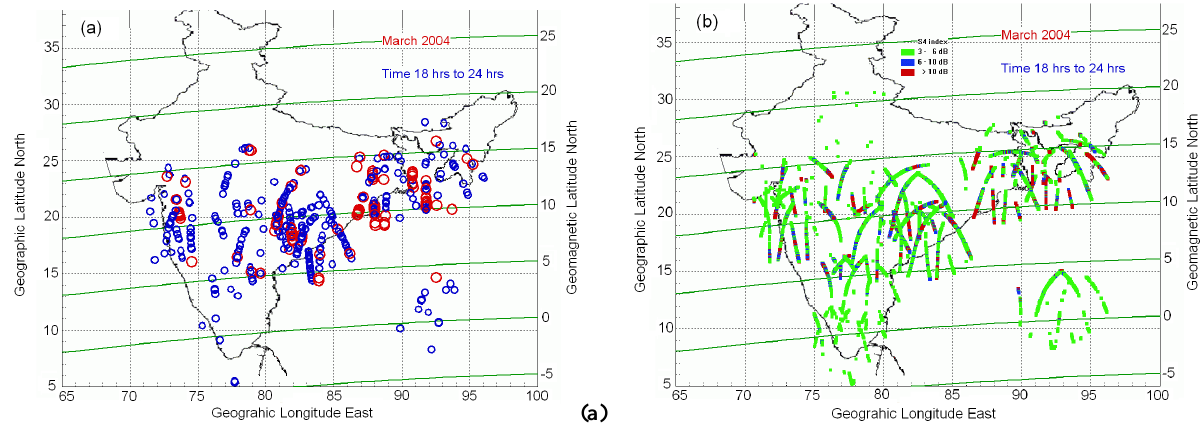
Fig. 6. Occurrence of L-band scintillations associated with TEC depletions (bubbles) and loss of lock events during the month of March 2004: (a) bubbles (blue circles) and loss of locks of the GPS receivers (red circles) and (b) the scintillations at three different power ranges of 3 to 6dB (Green), 6 to 10dB (Blue) and > 10dB (Red).